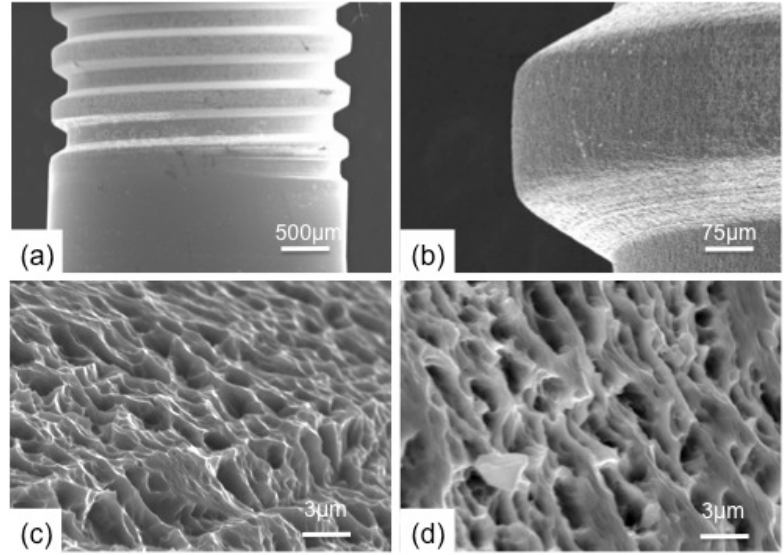
Figure 2. Characterization of implant surfaces by SEM. ( a , c ) implant without surface treatment; ( b , d ) implantation after coating with a thin film of hydroxyapatite (300 nm). ( b , d ) implantation after coating with a thin film of hydroxyapatite (300